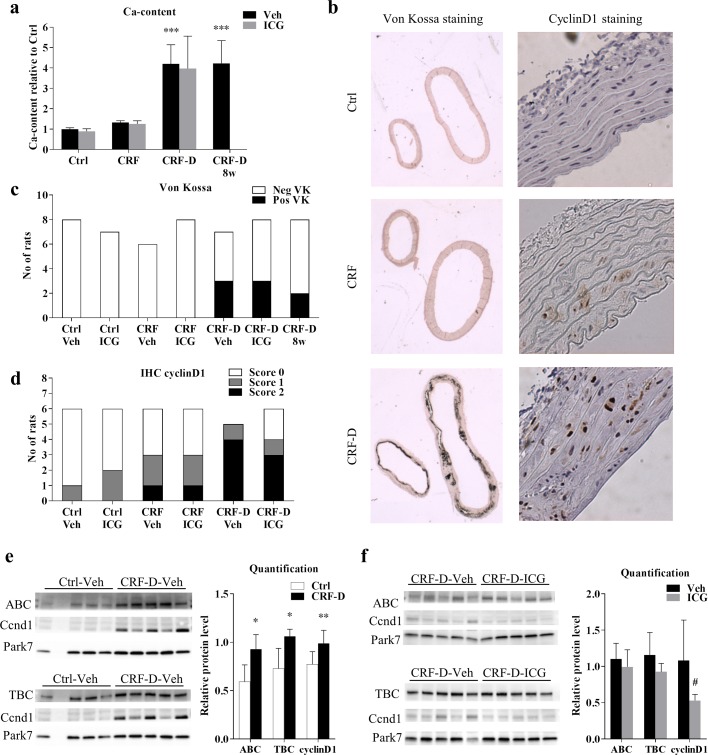
Aorta calcification and protein expression.Ca-content was determined in the proximal thoracic aorta. A marked increase in Ca-content was seen in CRF-D rats, while no difference was seen between CRF and Ctrl. No differences were seen in Ca-content between ICG-001- and vehicle-administered rats (a). Representative pictures of von Kossa and cyclinD1 stains are presented in (b). No Ctrl or CRF rats stained positive by VK. Three rats stained positive in both the ICG-001- and vehicle-administered CRF-D groups (c), and noticeably all rats staining positive by VK had massive, confluent staining, both in the proximal thoracic (right side of the image) and distal abdominal aorta (left side of the image). Aortic protein expression of cyclinD1 was examined by IHC (d). The majority of Ctrl rats stained negative and approximately half of the CRF rats stained positive for cyclinD1. No differences were noted between ICG-001- and vehicle-administered Ctrl and CRF rats. All vehicle-administered CRF-D rats stained positive for cyclinD1, while two ICG-001-administered CRF-D rats stained negative. CyclinD1, total β-catenin (TBC) and active β-catenin (ABC) protein levels were examined by WB in aortae from vehicle-administered Ctrl and CRF-D rats (e) and in aortae from ICG-001 and vehicle-administered CRF-D rats (f). Aortic protein levels of cyclinD1, total and active β-catenin were increased in vehicle-administered CRF-D rats compared to Ctrl, and protein levels of cyclinD1 were reduced in ICG-001-admininstered CRF-D rats compared to vehicle-administered CRF-D rats. Blots cropped from different parts of the same gel are presented together. Uncropped blots are provided in S1 Fig. Data is presented as mean ± SD. n = 5–9. Vehicle-treated Ctrl, CRF and CRF-D rats were compared by one-way ANOVA and Dunnets multiple comparison with ***P<0.001 vs Ctrl. ICG-001- and vehicle-administered groups were compared using unpaired two-tailed t-test with #P <0.05 vs vehicle. In WB (e) Ctrl and CRF-D rats were compared by unpaired two-tailed t-test with *P<0.05 and **P<0.001 vs Ctrl.